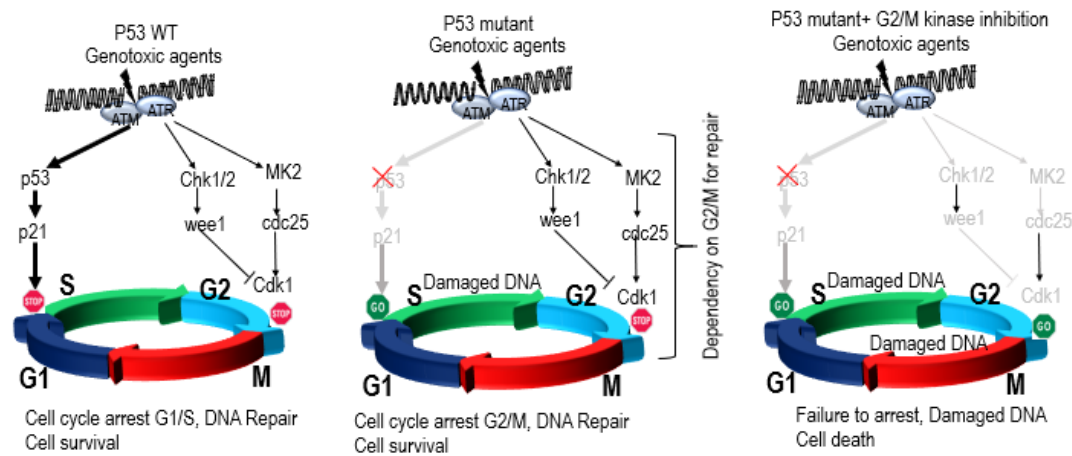
Figure 4. Mechanism of synthetic lethality of P53 with G2/M kinases: When cells are treated with genotoxic agents, they undergo a P53-mediated G1/S arrest to allow time for DNA repair, but in a P53-deficient background, the G1/S checkpoint is absent, and cells are dependent upon the G2/M checkpoint for survival.